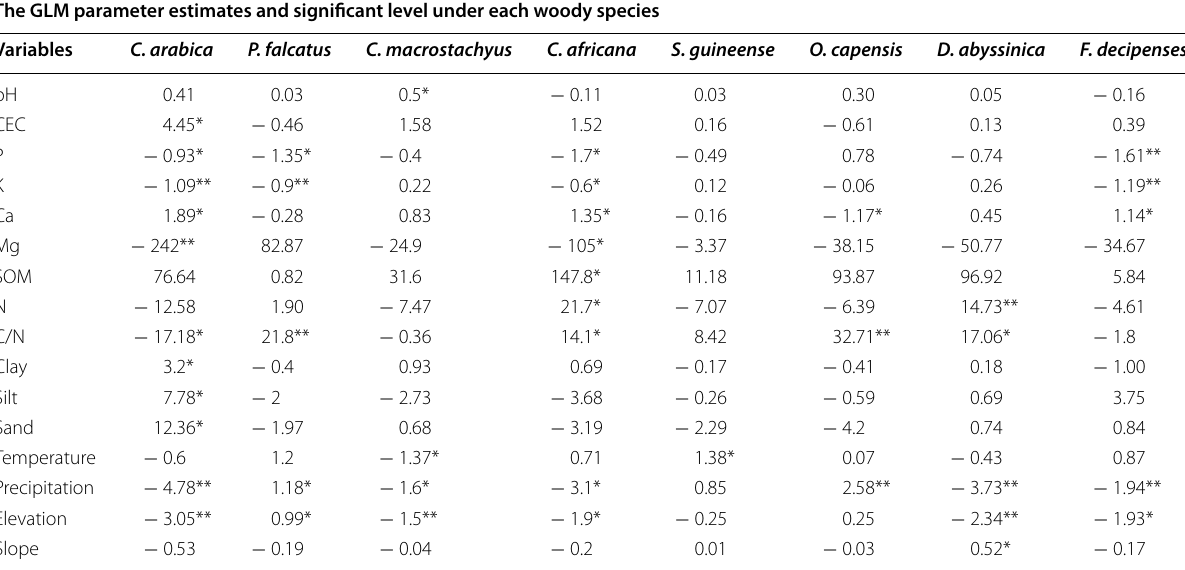
Significant at ** < 0.01; Significant * at <